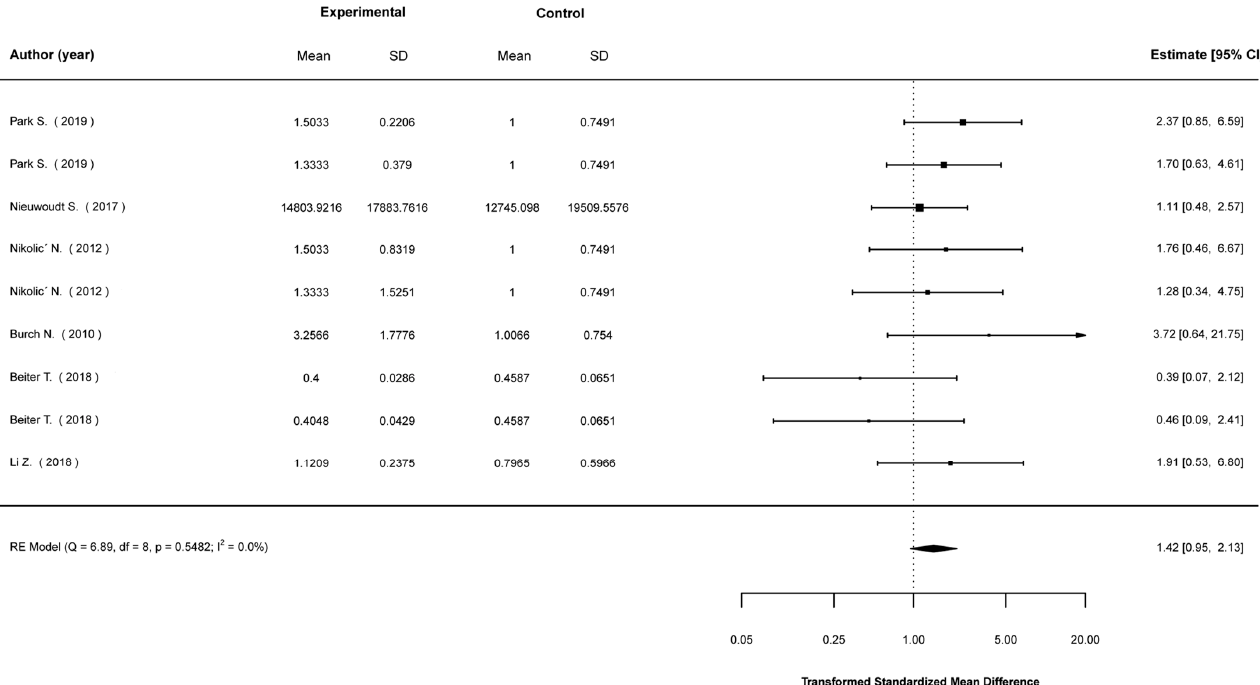
Figure 7. Findings of random-effects meta-analysis on the effects of EPS on GLUT4 compared to non-stimulated cells. Results shown are transformed standardized mean differences and 95% confidence intervals, as an estimate of the log odds ratio. Differences greater than 1.00 favour the EPS cells compared to non-stimulated control cells [16,17,21,29,45,48].